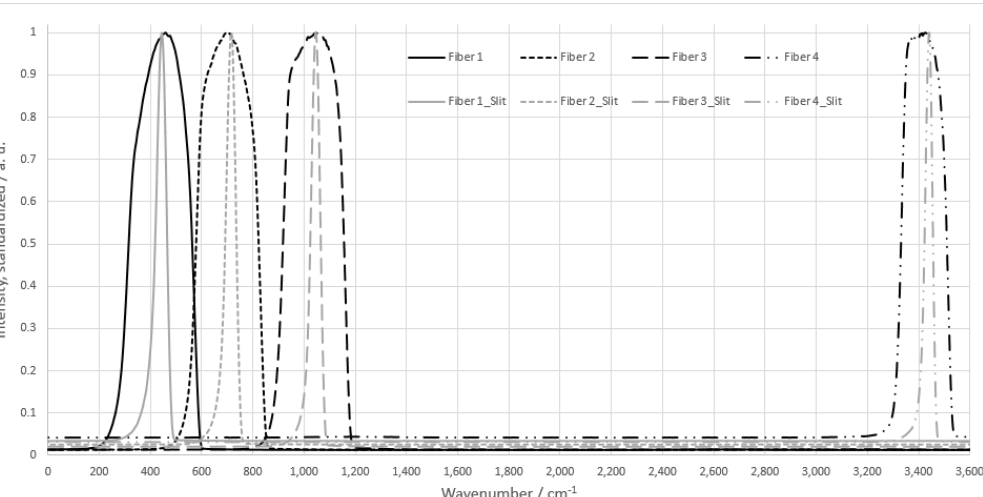
Figure 5. Reduction of the band width by slit mask in front of the fiber array standardized for visibility of improved spectral resolution. A halogen lamp was used as the light source, and the data were measured with a UV/VIS spectrometer (Zeiss, MCS621 VIS II, Jena, Germany).